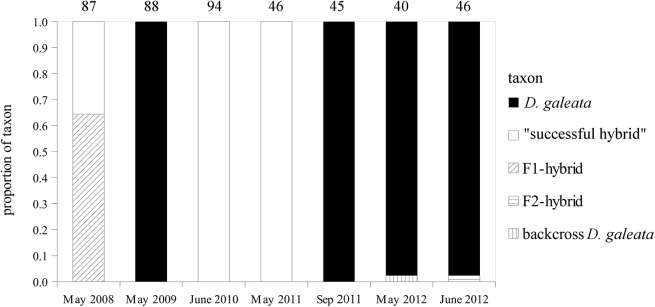
Daphnia taxon composition in the Feldmochinger See between 2008 and 2012, based on 15 microsatellite loci and NewHybrids assignment.The “successful hybrid” dominated the entire community in spring 2010 and 2011. The numbers above the bars show the number of genotyped individuals.